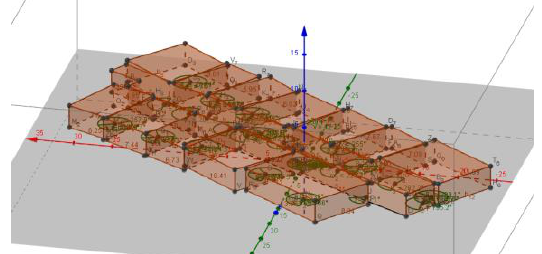
Figure 3: 3D Building modelling by Trimble LaserAce 1000 where dashed lines represent measured data from Trimble LaserAce 1000 and solid lines represent extruded floor plan.